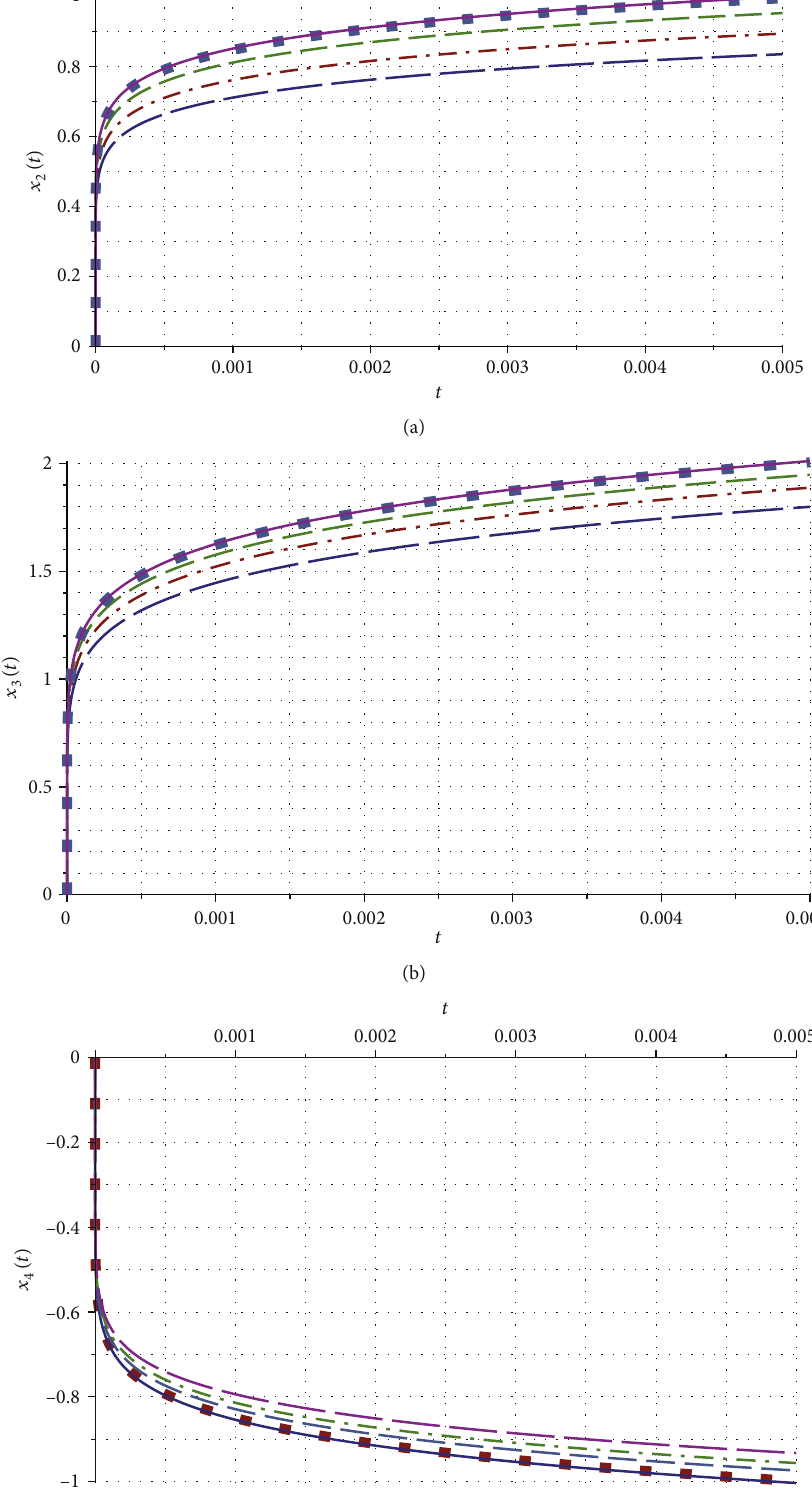
Figure 3: (a) Di ff erent values of α (OHAM-LS; α = 1 dot, α = 0 : 9 dash, α = 0 : 8 dash dot, and α = 0 : 7 long dash) and Rk4 ( α = 1 , solid) at x Di ff erent values of α (OHAM-LS; α = 1 dot, α = 0 : 9 dash, α = 0 : 8 dash dot, and α = 0 : 7 long dash), and RK4 ( α = 1 , solid) at x 3 : (c) Di ff erent values of α (OHAM-LS; α = 1 dot, α = 0 : 9 dash, α = 0 : 8 dash dot, and α = 0 : 7 long dash), and RK4 ( α = 1 , solid) at x 4